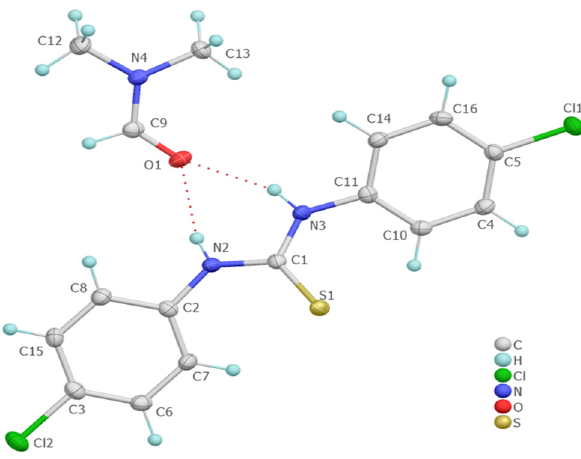
Figure 1: Crystalline structure of C 16 H 17 Cl 2 N 3